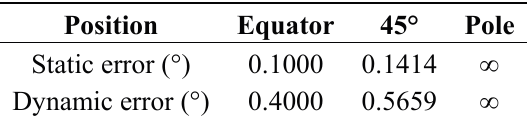
Table 2. Heading accuracy.